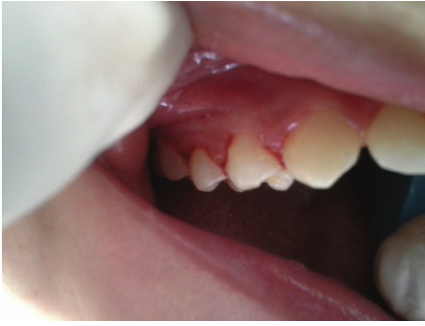
Figure 4: Oral manifestations after